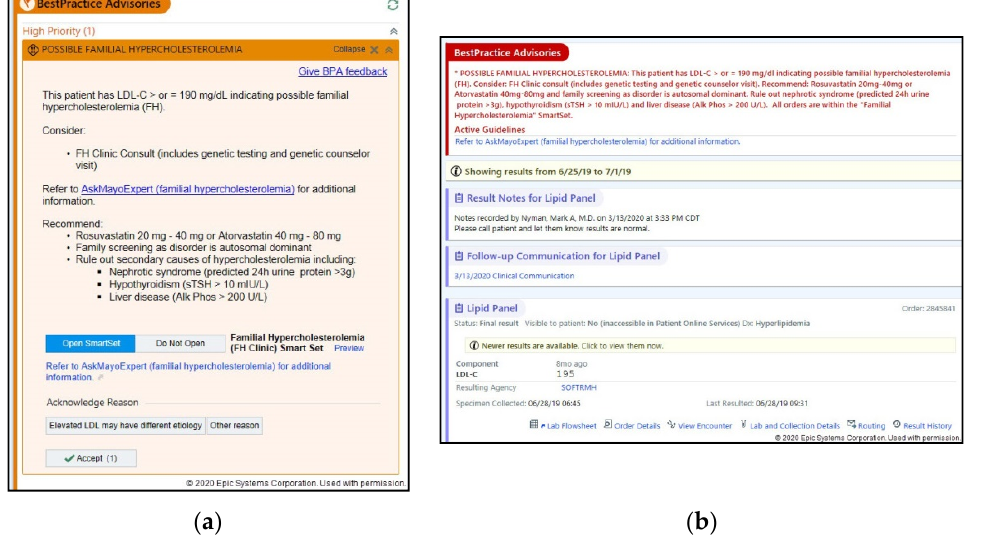
Figure 1. ( a ) The final best practice alert or BPA deployed in the EHR. ( b ) The final in-basket message linked to a lipid panel report, deployed in the EHR in silent mode.